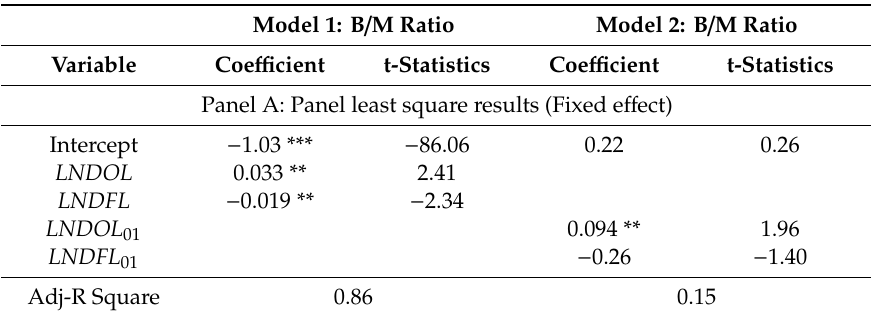
Table 5. B / M Ratio regression